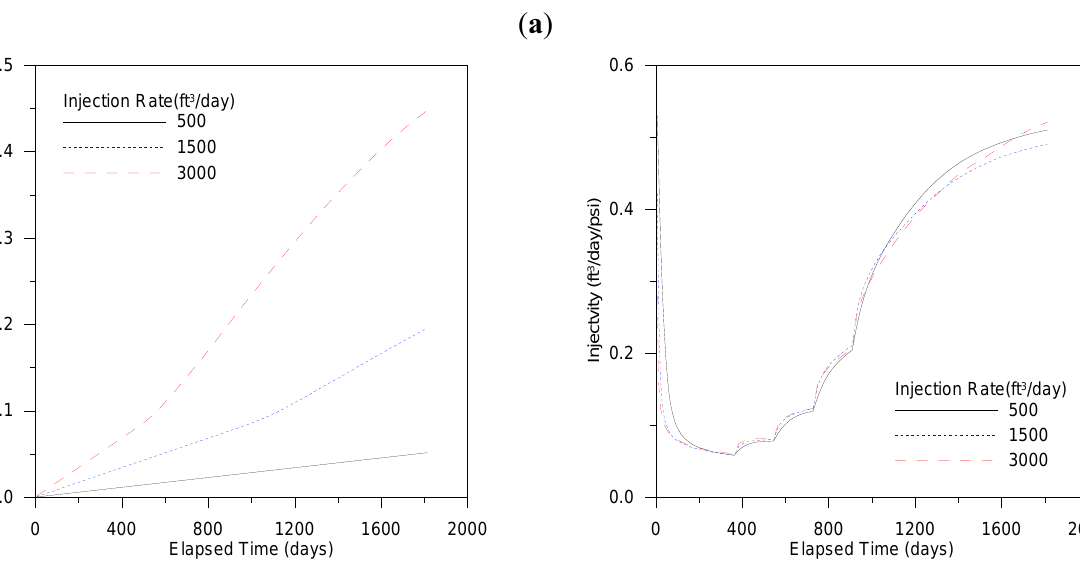
Figure 7. History of injection and production wells obtained from simulations for homogeneous reservoir with different